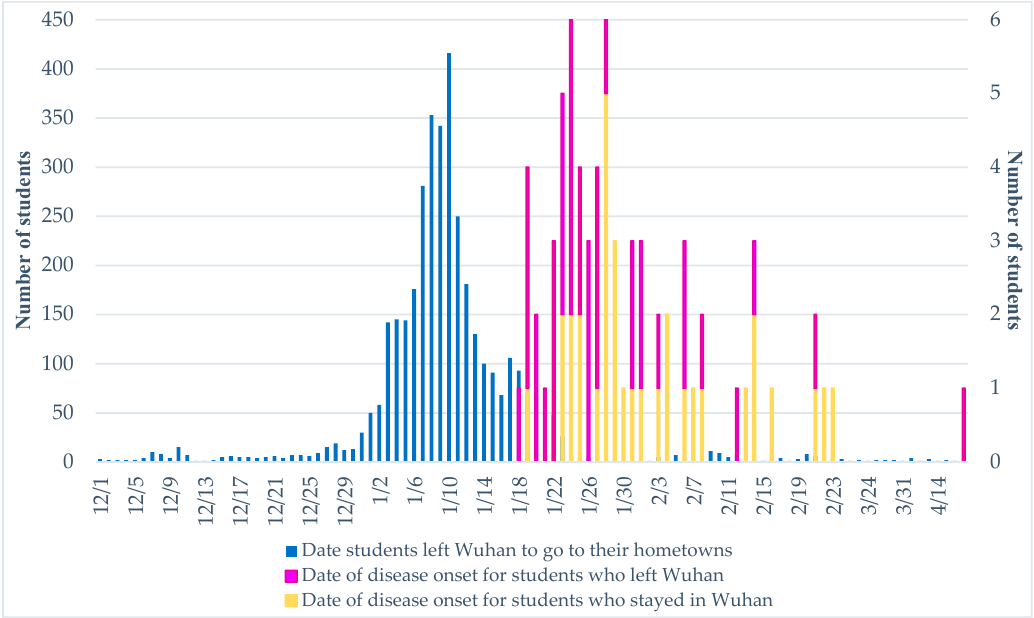
Figure 1. Epidemiological curves for the date students left Wuhan to go to their hometowns and the date of disease onset.